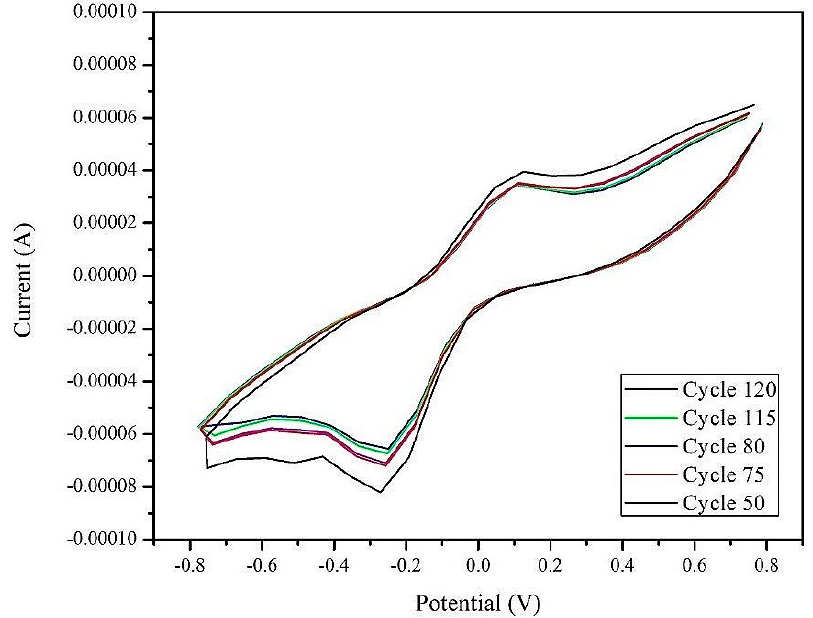
Figure 9. Stability of CuO–MBA–PAA/ITO electrode.